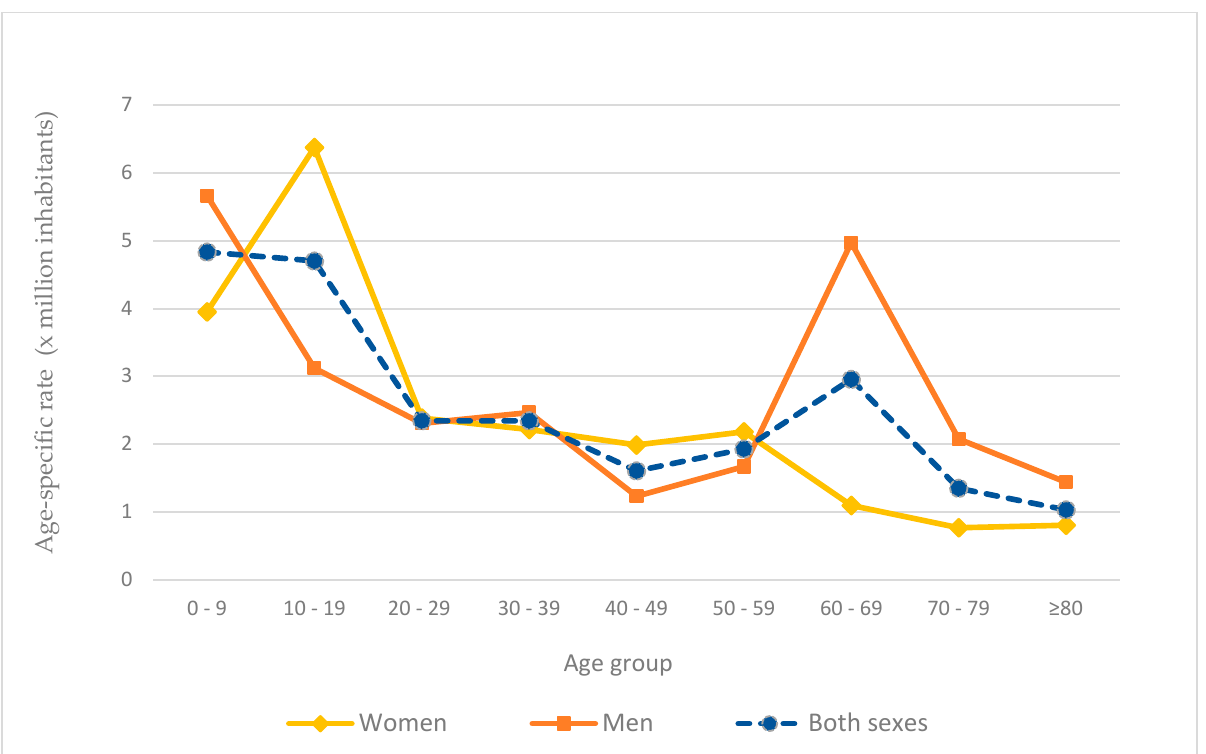
Figure 2. Age-specific hospitalization rates of patients with FMF in Spain by sex, 2008–2015. Throughout the period studied, the age-adjusted hospitalization rates for both sexes ranged from 2.47 (95% CI: 0.70–4.73) per million inhabitants in 2008 to 3.35 (95% CI: 1.29– 5.41) per million in 2015 (Figure 3). For both sexes, the average annual increase is 4.9% per year (95% CI: 2.20–7.63; p < 0.05). The rate among women was 2.28 per million (95% CI: 1.56–2.99) in 2008 and 4.05 (95% CI: 3.11–4.49) in 2015, showing a rising trend in cases (APC = 8.67%, 95% CI: 5.2–12.3; p < 0.05). In the case of men, the rate varied from 2.68 per million inhabitants (95% CI: 1.97–3.39) to 2.70 per million (95% CI: 1.96–3.43), though this variation was not significant ( p = 0.890).